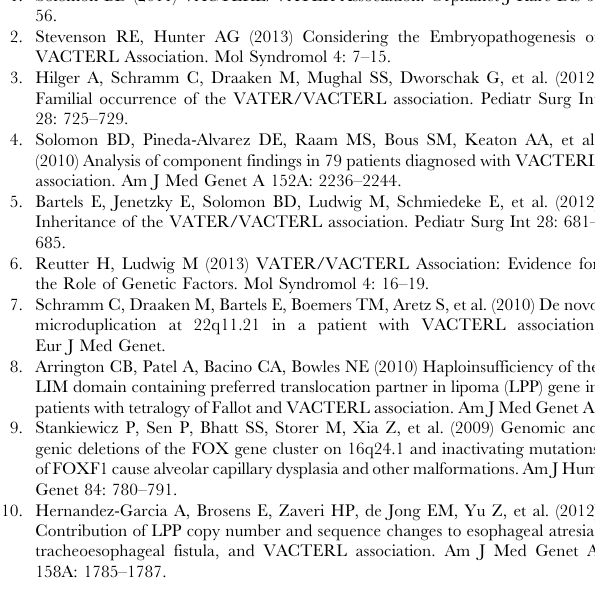
Table S3 Protein-protein interactions between proteins